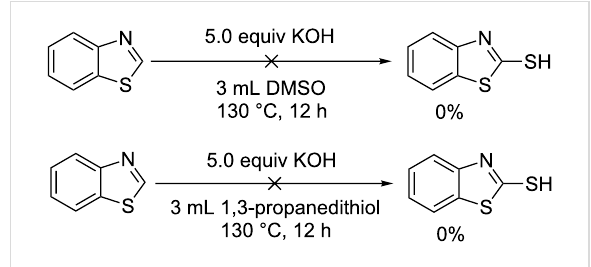
Scheme 2: Control